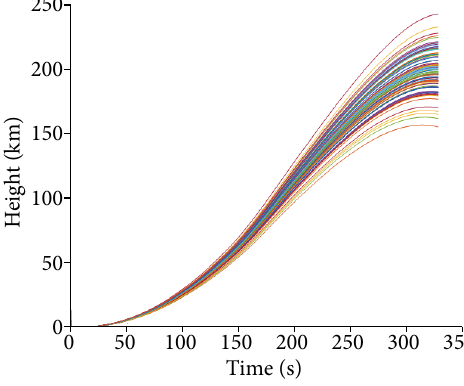
Figure 6. The effect of uncertainties on SLV height with deterministic optimal design.